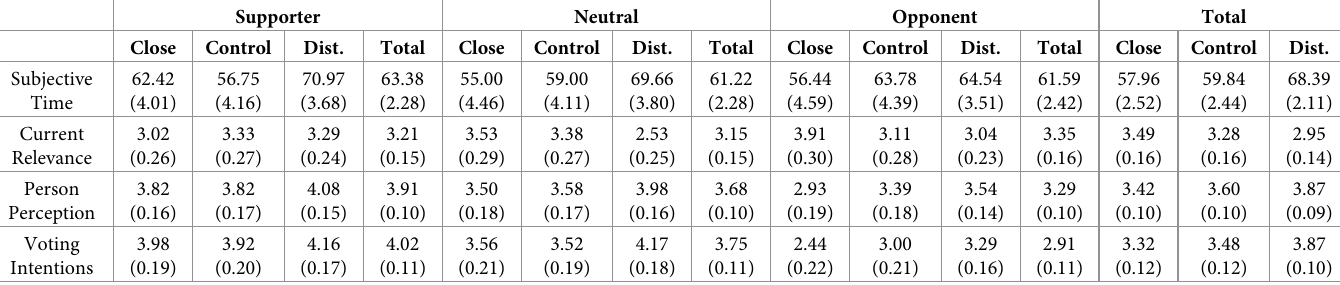
Table 5. Estimated marginal means and standard errors by cell for each of the dependent variables.